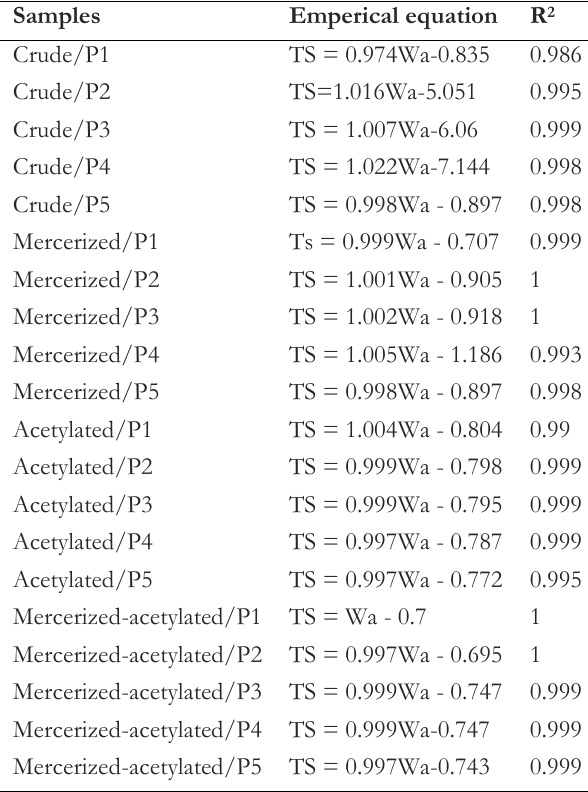
Table 11. Relationship between thickness swelling and moisture absorption of bamboo fibre polyester